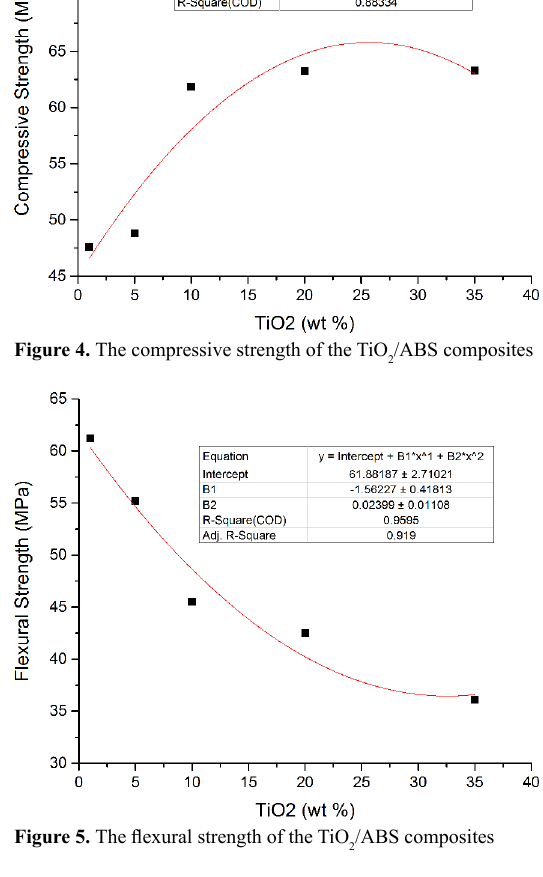
Figure 5. The flexural strength of the TiO